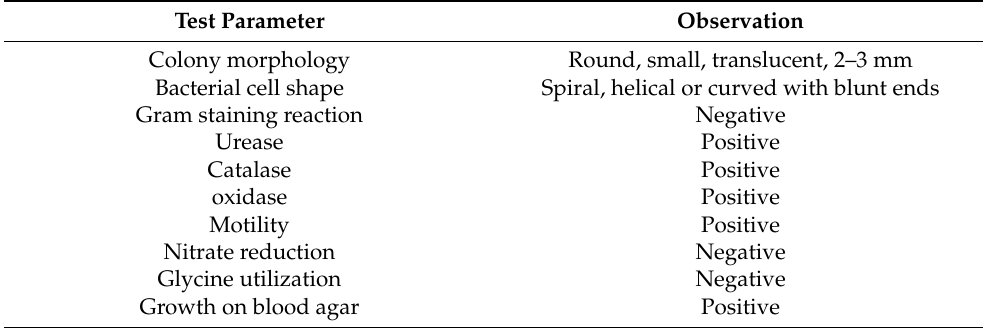
Table 2. Morphological and biochemical characteristics detected among H. pylori isolates.